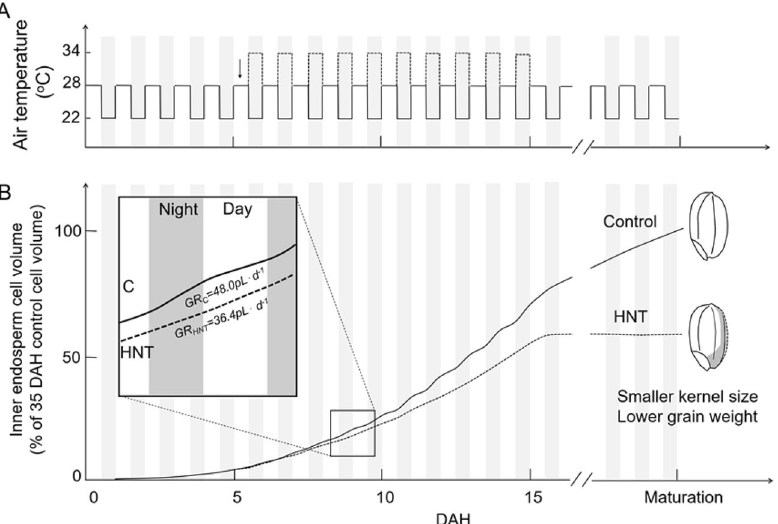
Figure 5. Air temperature setting of 10 day HNT treatment conducted during early ripening stage in this study ( A ). Arrow in ( A ) indicates initiation of HNT treatment. Putative changes in cell volume in inner endosperms under HNT conditions throughout development ( B ) (see Fig. 1). The graph was generated based on the cell volume data shown in Fig. 1F, assuming that cell growth rate during daytime was similar to control. Inset in ( B ) shows expanded putative diurnal growth curve, and the cell growth rate ( GR ) in control and HNT was estimated to be 48.0 pL . d −1 and 36.4 pL . d −1 , respectively. Solid and dashed lines in ( A ) and ( B ) indicate control and HNT treatment,